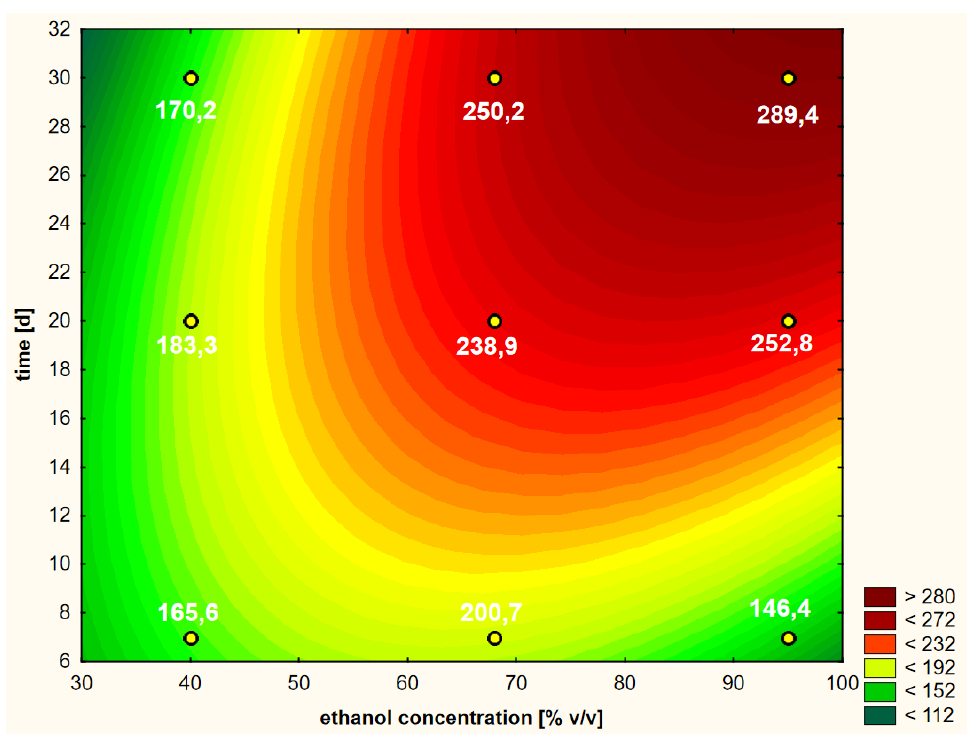
Figure 9. Model of the response surface concerning the contents of chlorogenic acid in ethanol extracts of elderberry flowers obtained from previously frozen raw material that was initially treated with cold ethanol at a temperature of 25 °C.